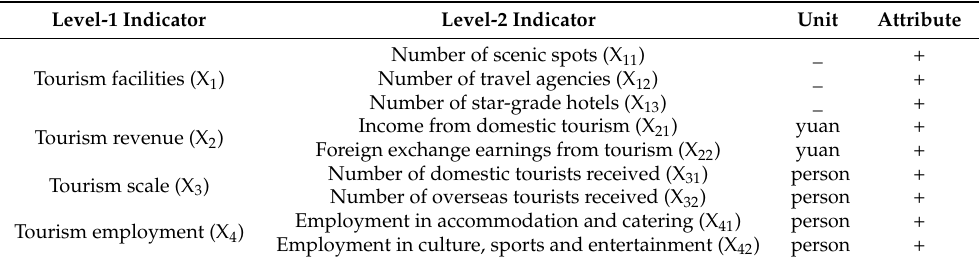
Table 1. The index system of tourism economic development level in southern